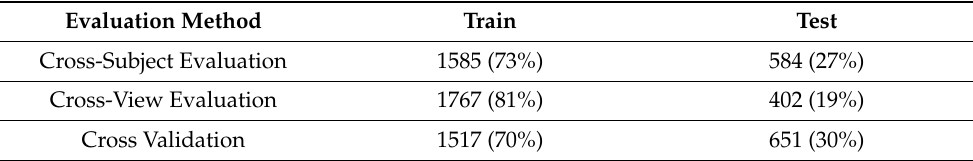
Table 3. Data division under three evaluation standards.